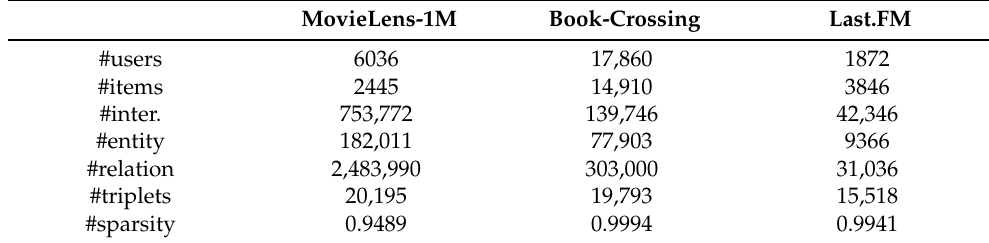
Table 1. Statistical information for the three